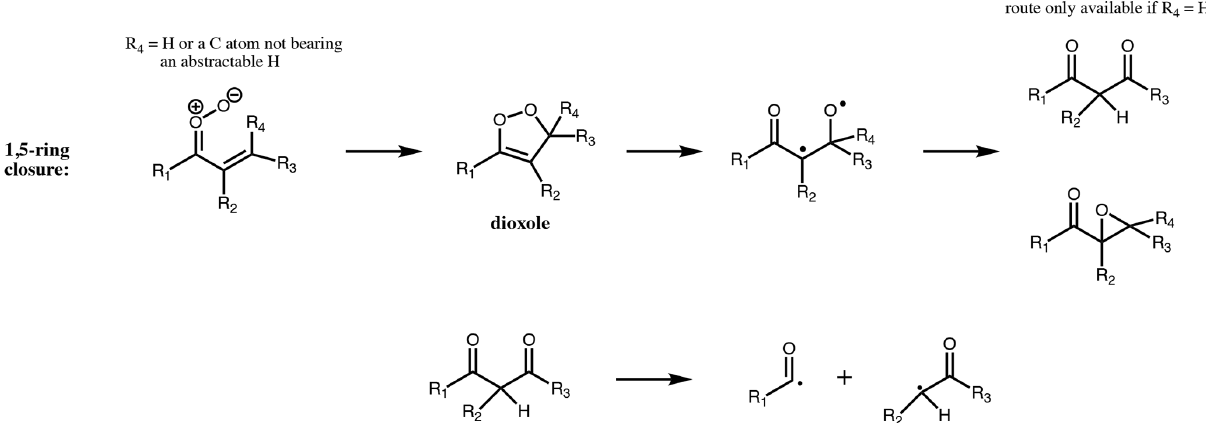
Figure 8. 1,5 ring closure: dominant unimolecular pathway for unsaturated CI with the terminal oxygen syn to an α vinyl group, and R 4 is not a carbon with an abstractable